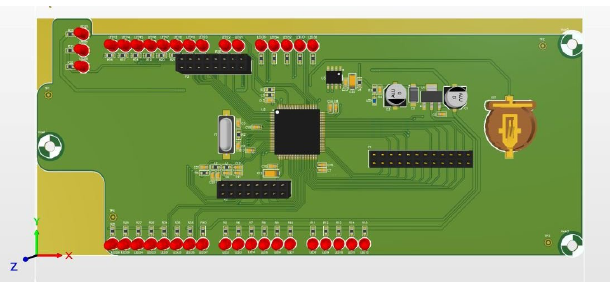
Figure 4. The PCB layout of our sensor nodes